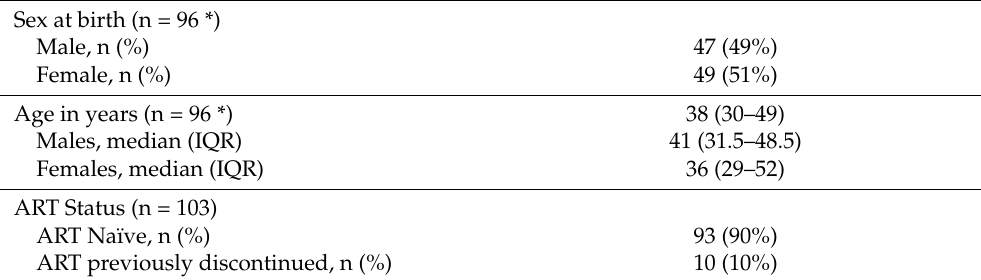
Table 1. Participant